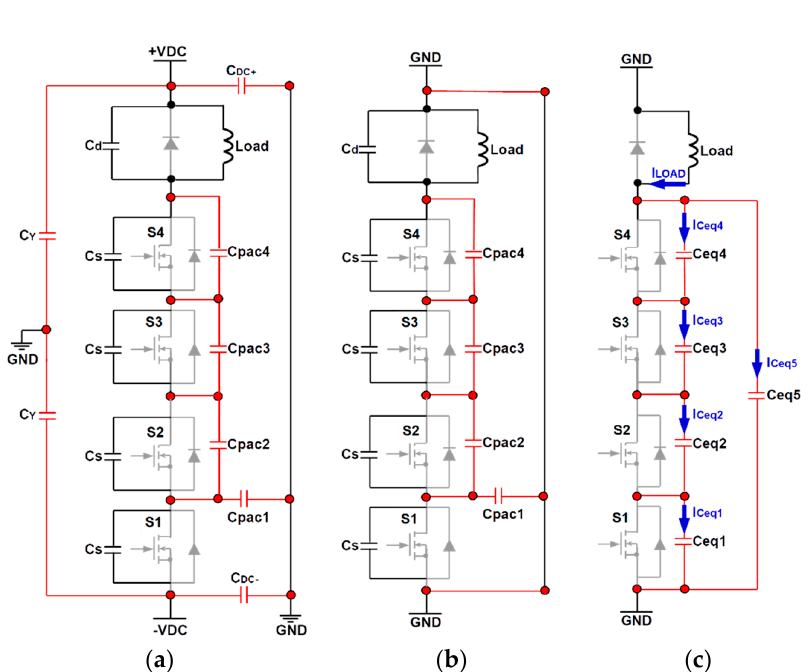
Figure 8. Electrical scheme of four SiC-MOSFETs connected in series in the MSP ( a ), high-frequency circuit ( b ), and simplified electrical scheme ( c ).